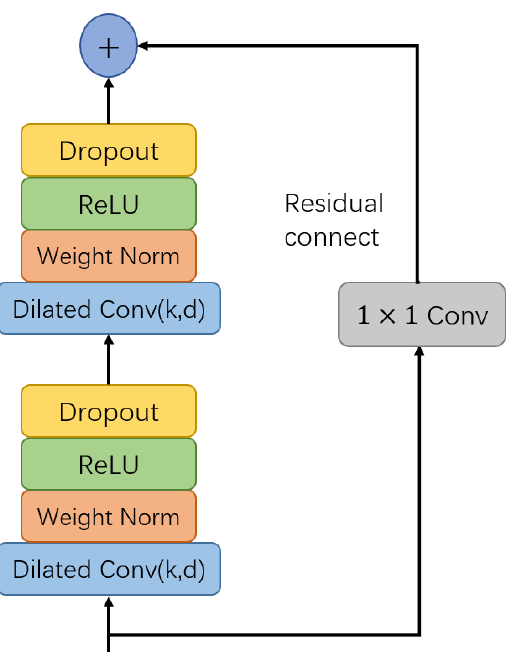
Figure 2. A simple implementation of the TCN residual block using in the experiment. k represents the kernel size and d represents the dilation base.